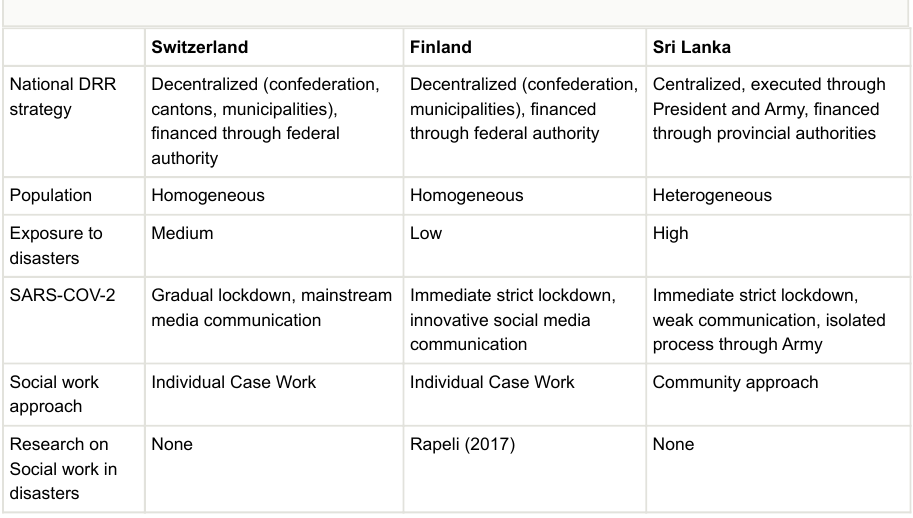
Table 1. Specifications of the field